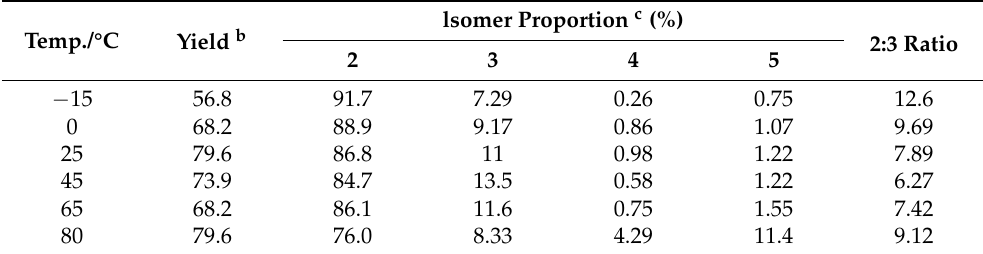
Table 4. Effect of reaction temperature a .